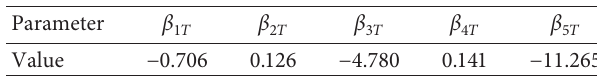
Table 3: The values of parameters of critical moment 􏽥 M (equation (17)).